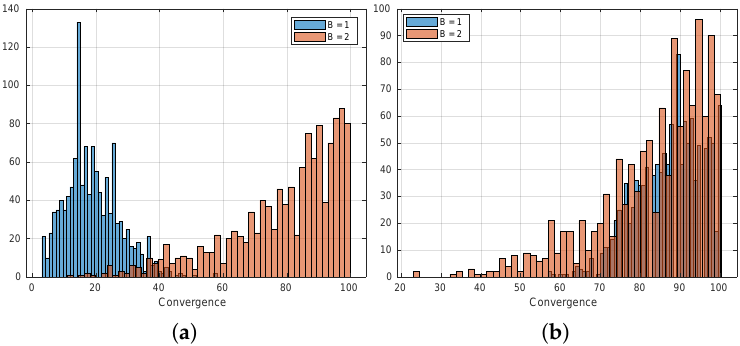
Figure A29. Histograms for the conclusions about the effect of factor B on the convergence performance, represented for the two levels of such factor with additional restrictions on the population. ( a ) Factor C = 1. ( b ) Factor C =